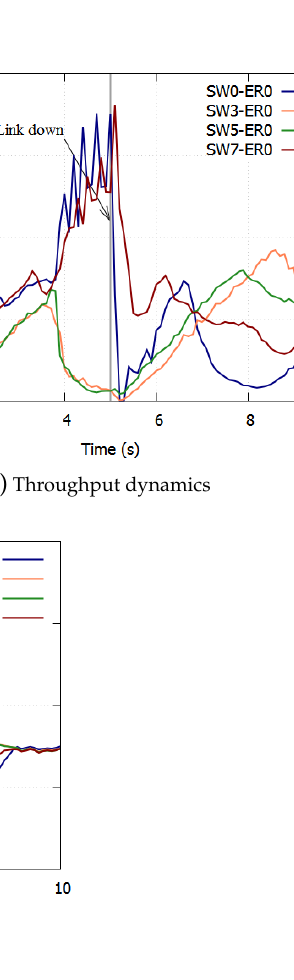
Figure 9. Result with existing NRN +